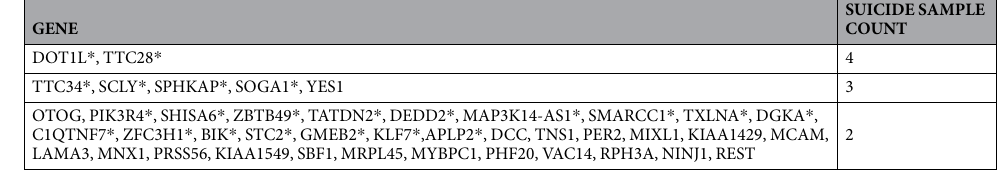
Table 3. List of putative dominant loss of function candidate genes where at least two samples had rare potentially damaging variants exclusively in the suicide samples.Each variant was a heterozygote and only counted if located in the same transcript of the gene. The GENE column contains the identified genes, the SAMPLE COUNT column contains the number of suicide samples in which a rare potentially damaging variant was found in the given genes. * denotes genes without disease association in MalaCards and OMIM.